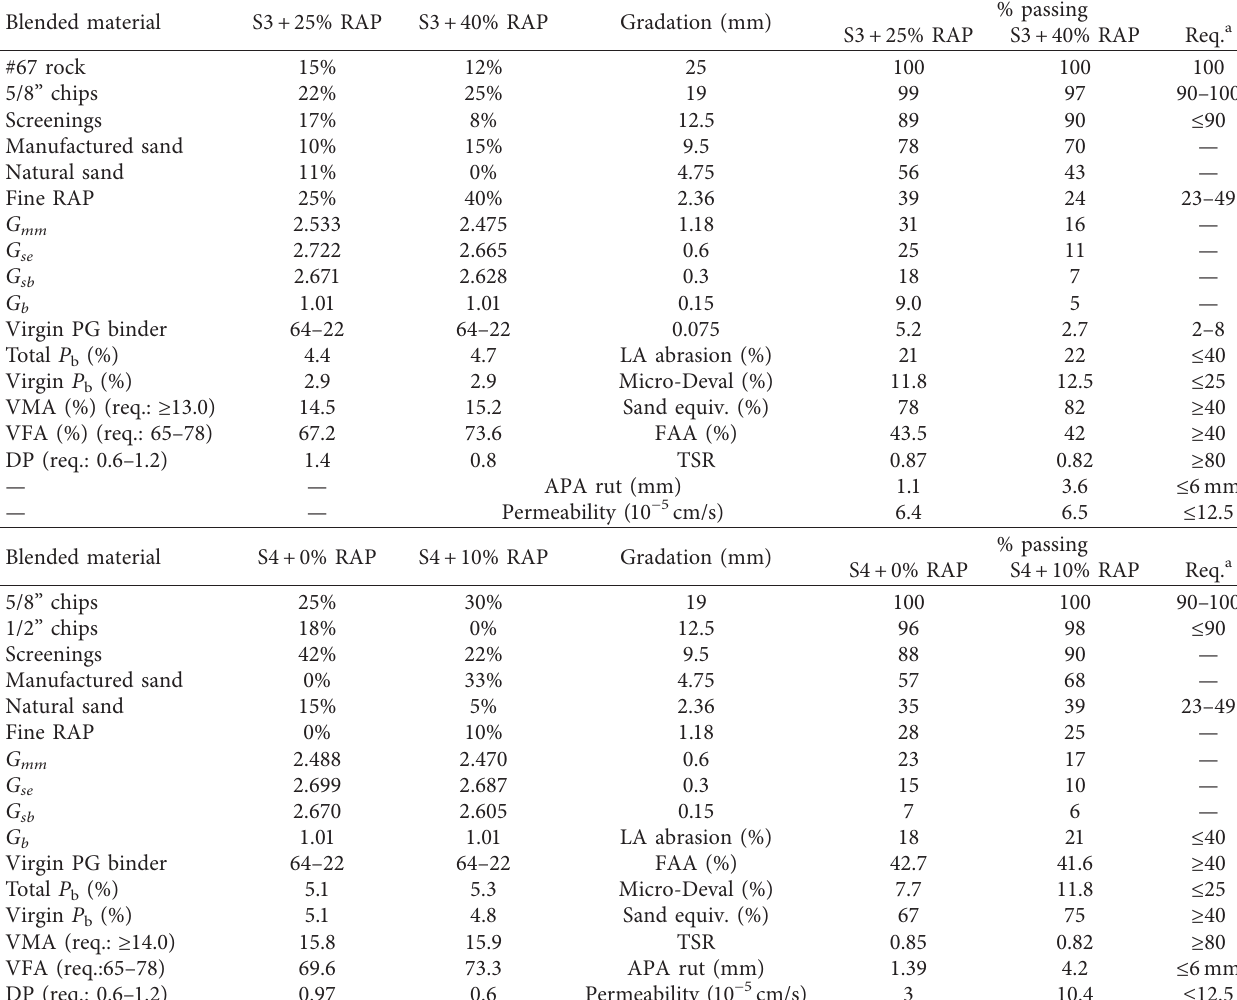
Table 1: Gradation and volumetric properties of S3 and S4